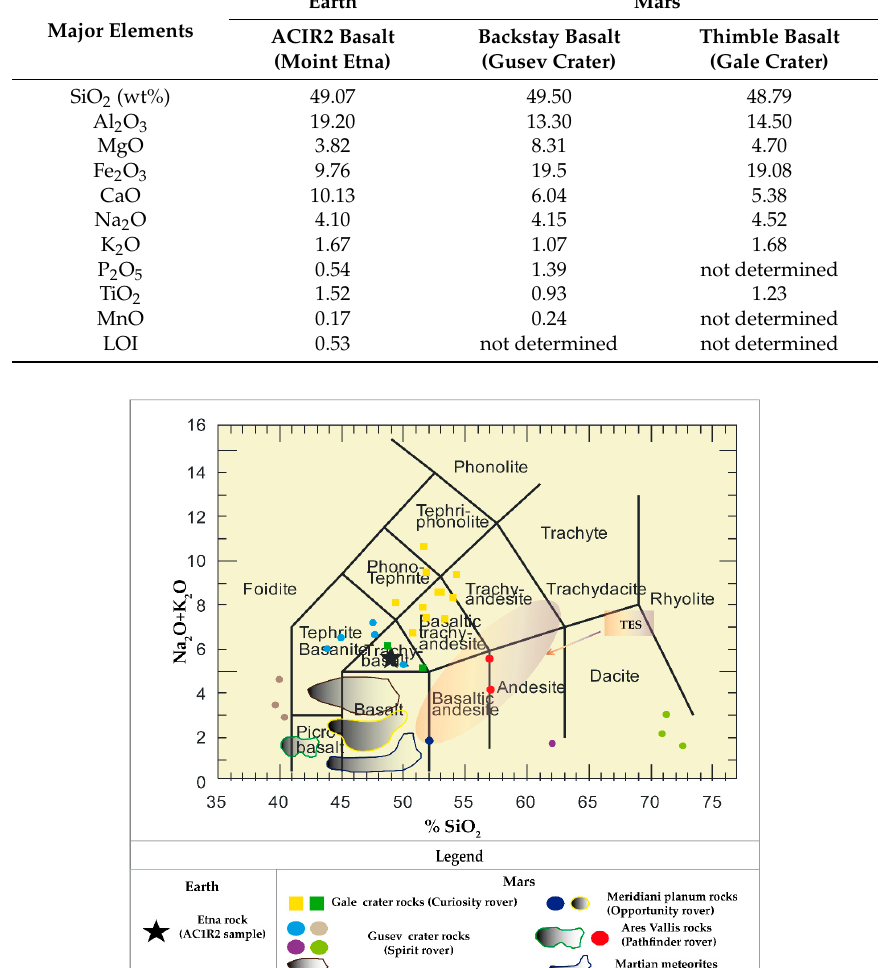
Table 2. Chemical composition of major elements (wt%) of sample AC1R2 obtained using X-ray fluorescence and comparison with the Blackstay [54] and the Thimble basalt [55] chemical composition acquired in Gusev and Gale craters landing sites on Mars using Alpha particle X-ray spectrometer (APXS) (Jet Propulsor Laboratory, Pasadena, CA, USA) and ChemCham (Lockheed Martin Astronautics and Jet Propulsor Laboratory, USA) instrument, respectively. LOI: loss on ignition.